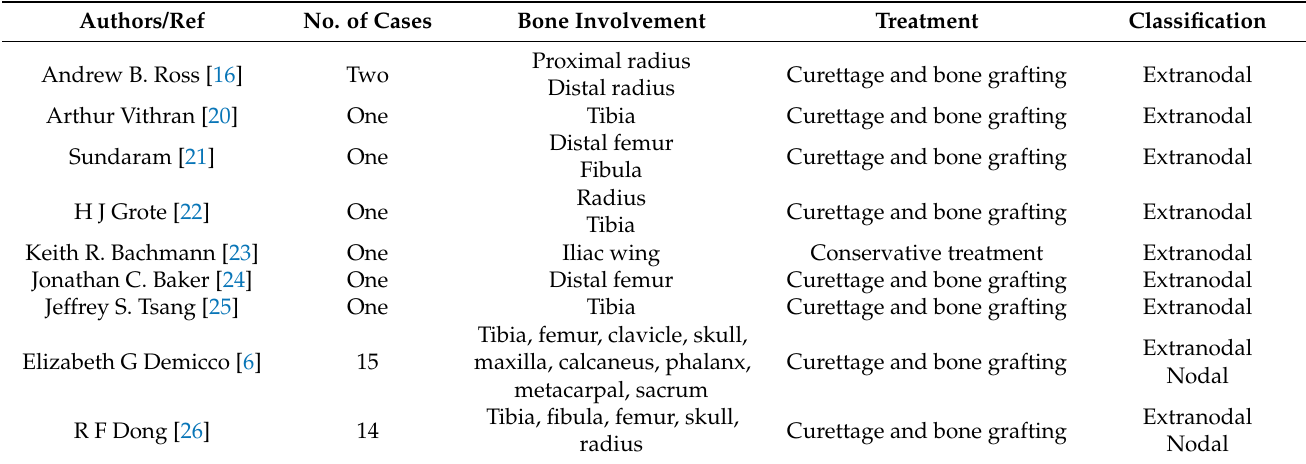
Table 2. Literature review, number of cases, bone site, treatment and type of